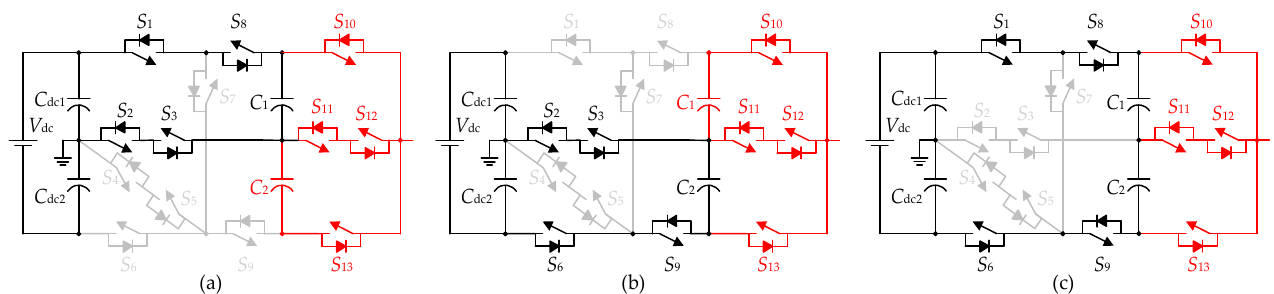
Figure 4. Switching states when ( a ) approach I is realized and C 1 is used, ( b ) approach I is realized and C 2 is used, and ( c ) approach II is realized.